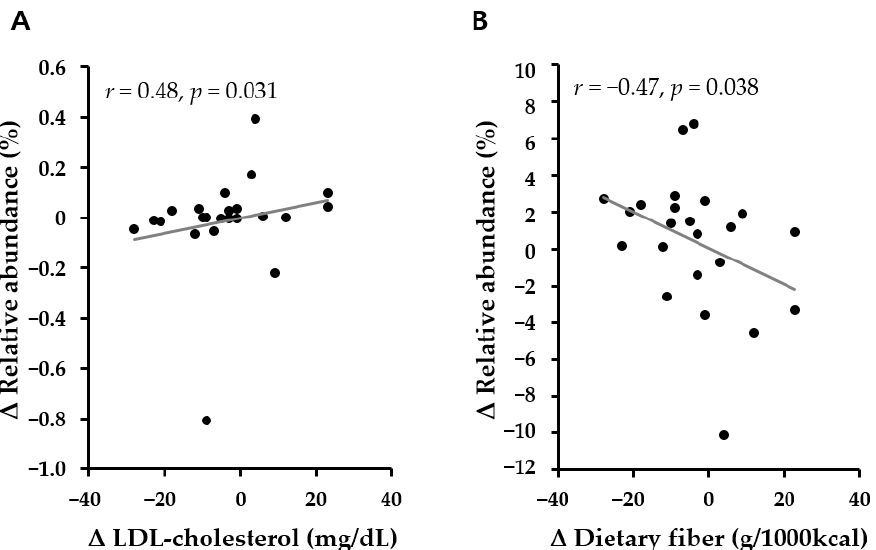
Figure 4. The correlation between changes in Romboutsia and ( A ) LDL-cholesterol and ( B ) dietary fiber over a period of baseline to 6 months ( ∆ ). Spearman’s partial correlation analyses adjusted for age, sex, and baseline BMI z-score were performed.